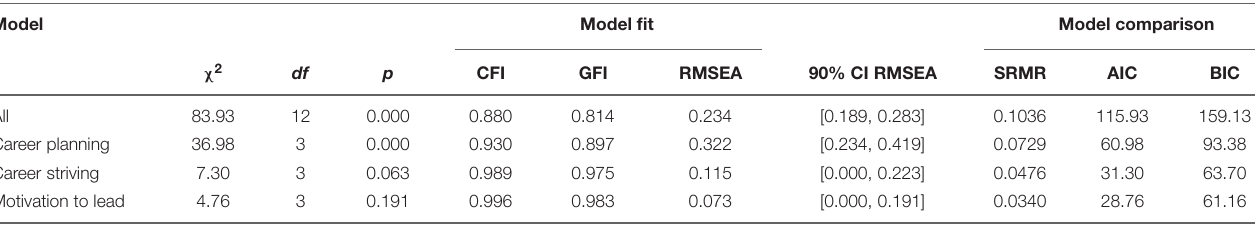
TABLE 4 | Model fit indices and model comparison for the path models in Study